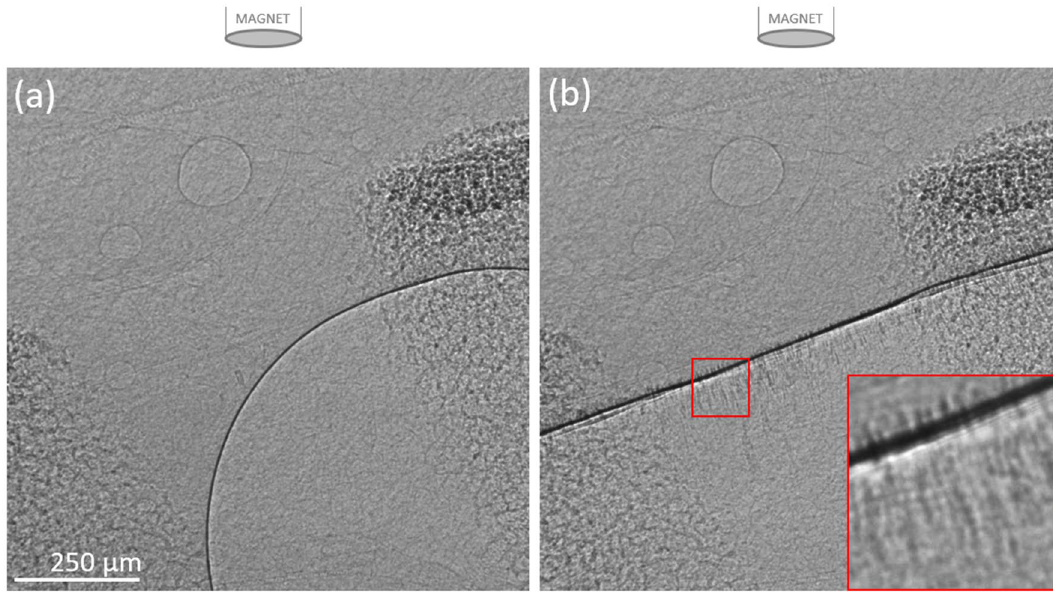
Figure 7. Images from ( a ) before and ( b ) immediately after delivery of MP5 into the trachea of a recently euthanized rat, with the magnet located directly above the imaging region. The imaging region is between two cartilage rings. Some fluid was present in the airway prior to MP delivery. The red box contains a contrast- enhanced enlargement. These images are from the video shown in Supplementary Video S6: MP5.